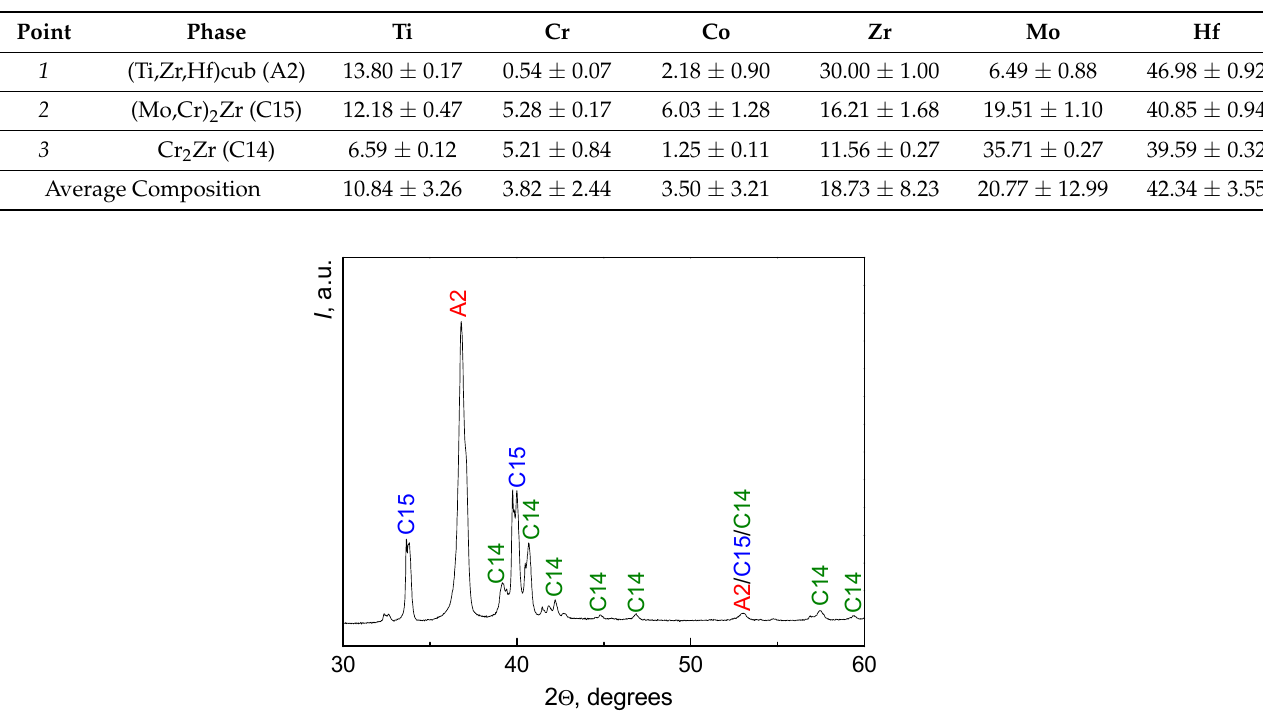
Table 1. The total component composition of the TiZrHfMoCrCo alloy and its individual re- gions (wt.%).